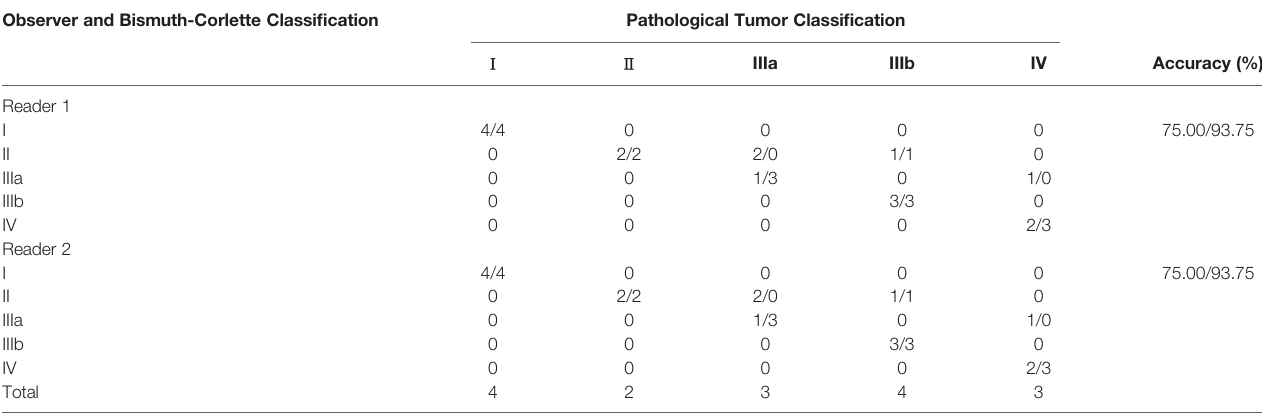
TABLE 5 | Correlation of Bismuth Corlette Classi fi cation of Hilar Cholangiocarcinoma with the Pathological Findings using the DWI Study Interpretation. Observer and Bismuth-Corlette Classi fi cation